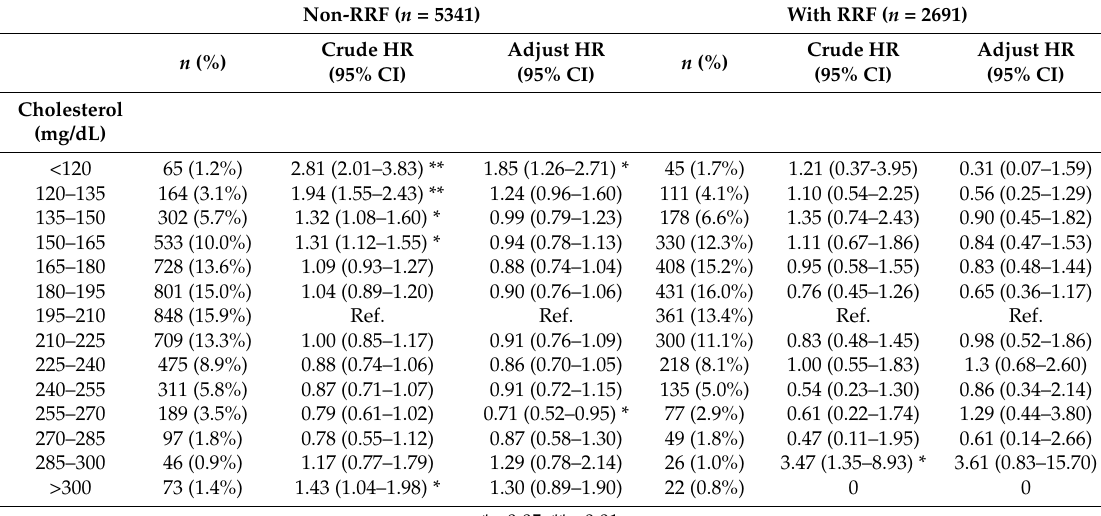
Table 2. Association with total cholesterol and mortality in stratification of RRF.